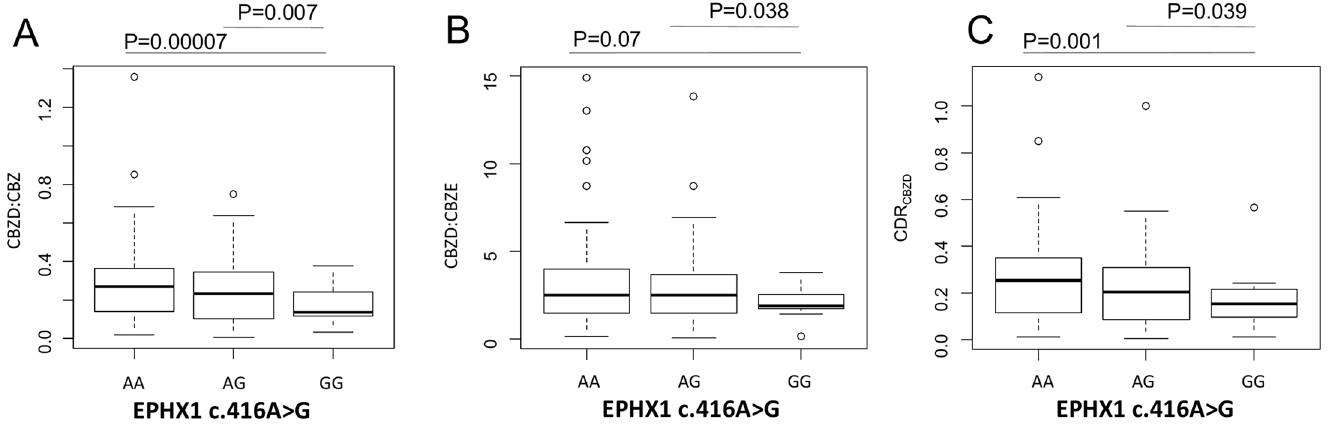
Fig 4. Graphical representations (box-plot) of the EPHX1 c.416A > G genotypes associations with (A) CBZD:CBZ, (B) CBZD:CBZE and (C) CDR CBZD ,. CBZ: Carbamazepine; CBZD: Carbamazepine-10,11-trans dihydrodiol; CBZE: Carbamazepine-10,11-epoxide; CDR: Concentration/dose ratio. Data are mean ± standard deviations. Statistical significance for difference of means is shown (P values, one way ANOVA analysis followed by Student ’ s T- test).